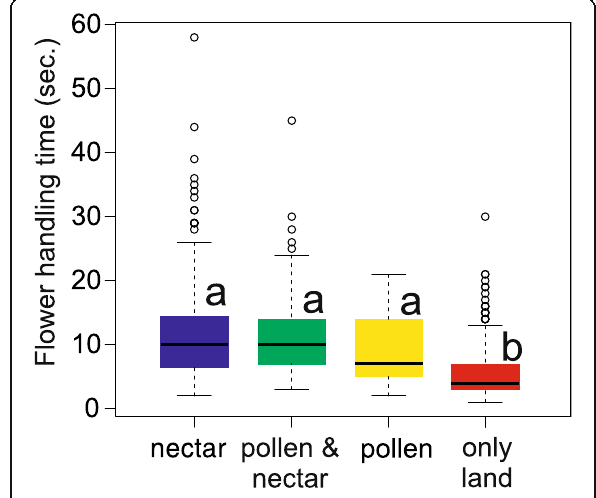
Fig. 2 Handling time and floral resource(s) collected by bees in avocado flowers, Hijuelas orchard, Valparaíso Region, Chile. Statistical analysis: χ 2 = 192.1, d.f. = 4; p ≤ 0.001, GLMM (Negative Binomial